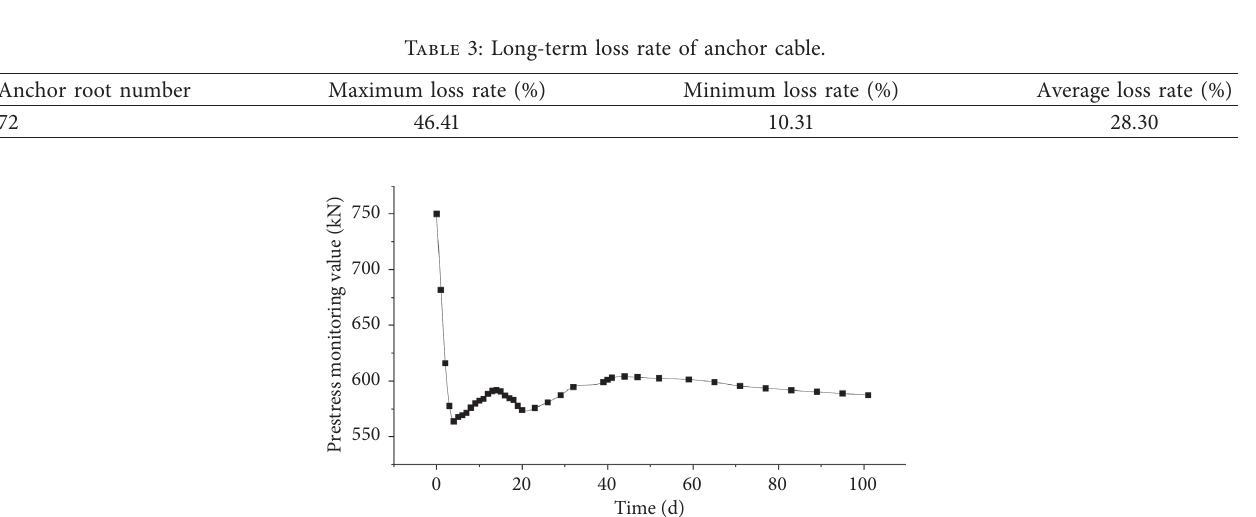
Figure 5: Prestress monitoring values for first-row 750kN anchor cable located at K5 +420.